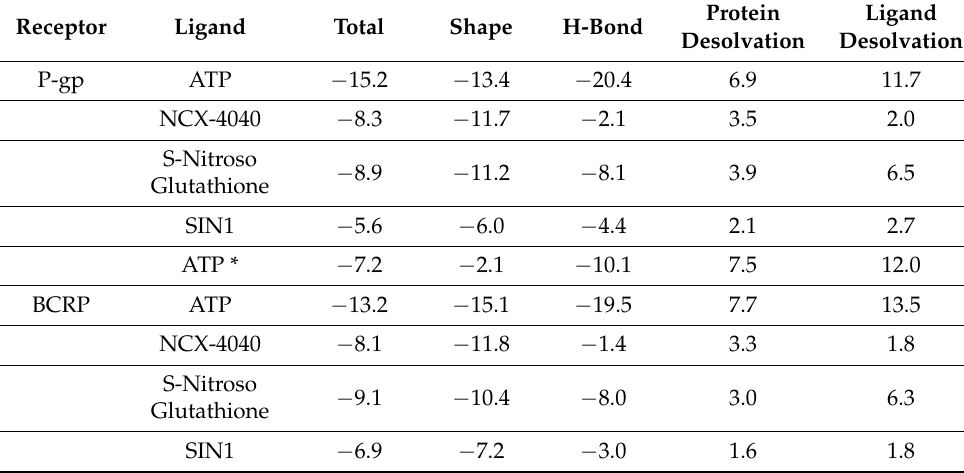
Protein Ligand Desolvation Desolvation